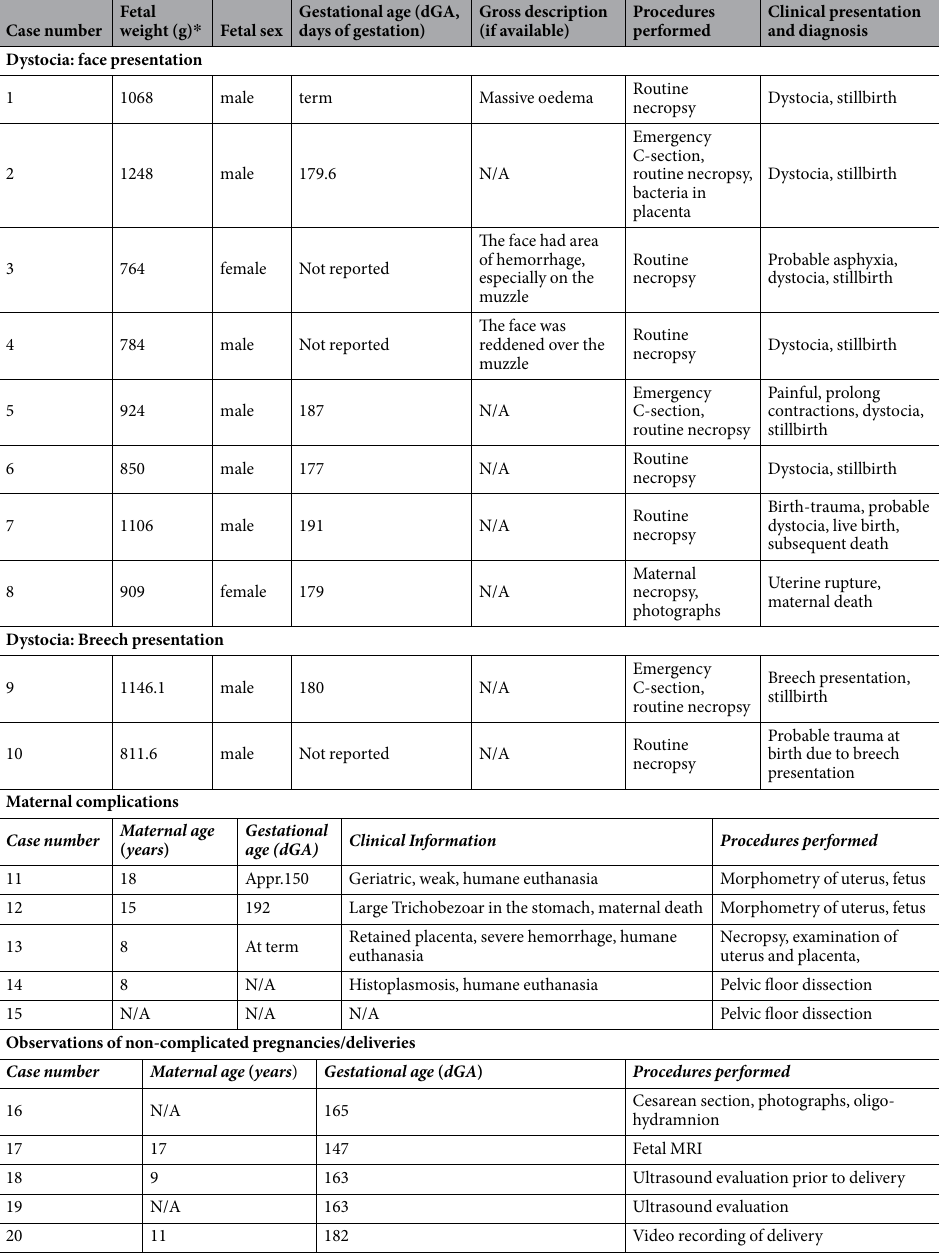
Table 1. Characteristics of the animals and procedures described in the study. (N/A designates that information did not apply to a particular entry or not available); * the reported weight of healthy newborn baboons at the SNPRC colony is 888 g (min 480 g and max 1200 g) 39